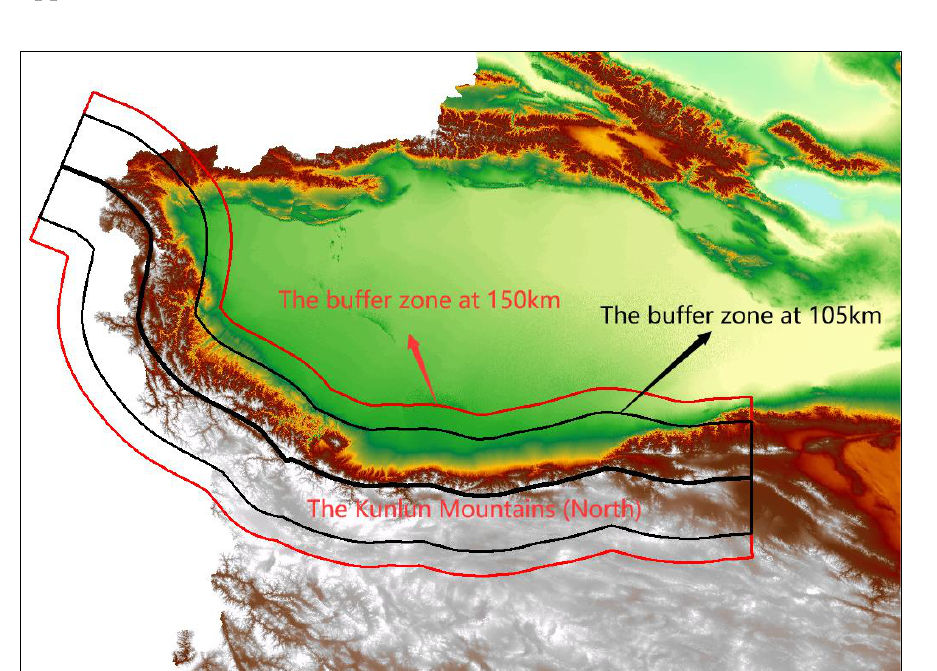
Figure A1. The buffer zones at 105 km and 150 km set for the Kunlun Mountains on both its sides. The black line for the buffer zone at 105 km is large enough to cover the coverage of the Kunlun Mountains and their foothills and nearby lands.